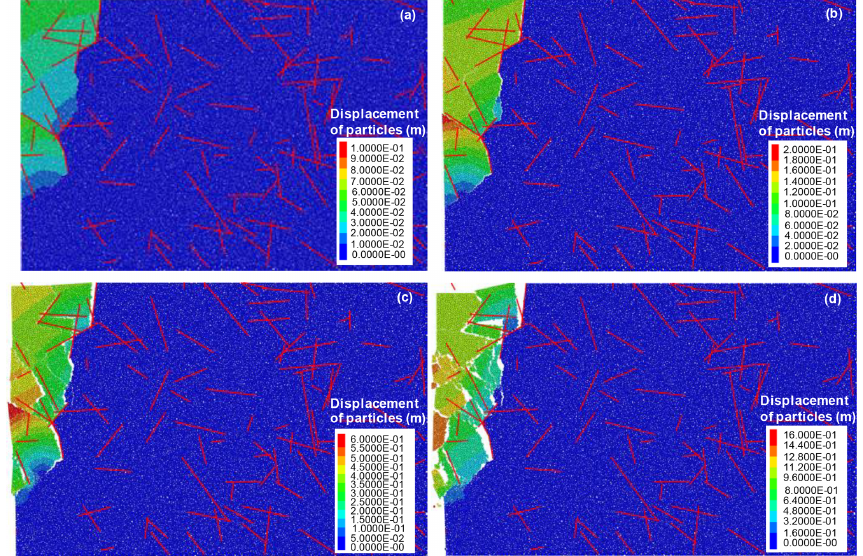
Figure 9. Particle displacement field of the fractured rock slope. The time steps of (a)–(d) are 2 × 10 4 , 4 × 10 4 , 6 × 10 4 , and 8 × 10 4